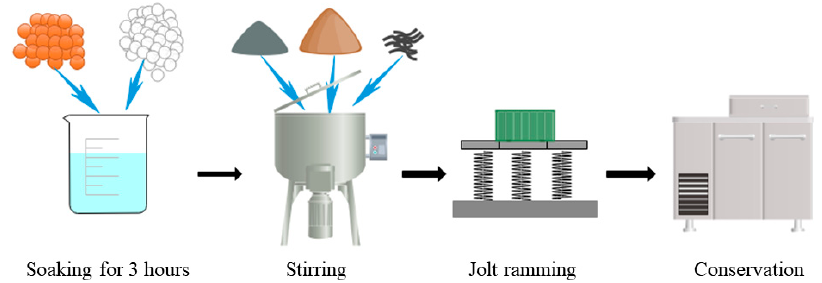
Figure 2. Specimen production process.